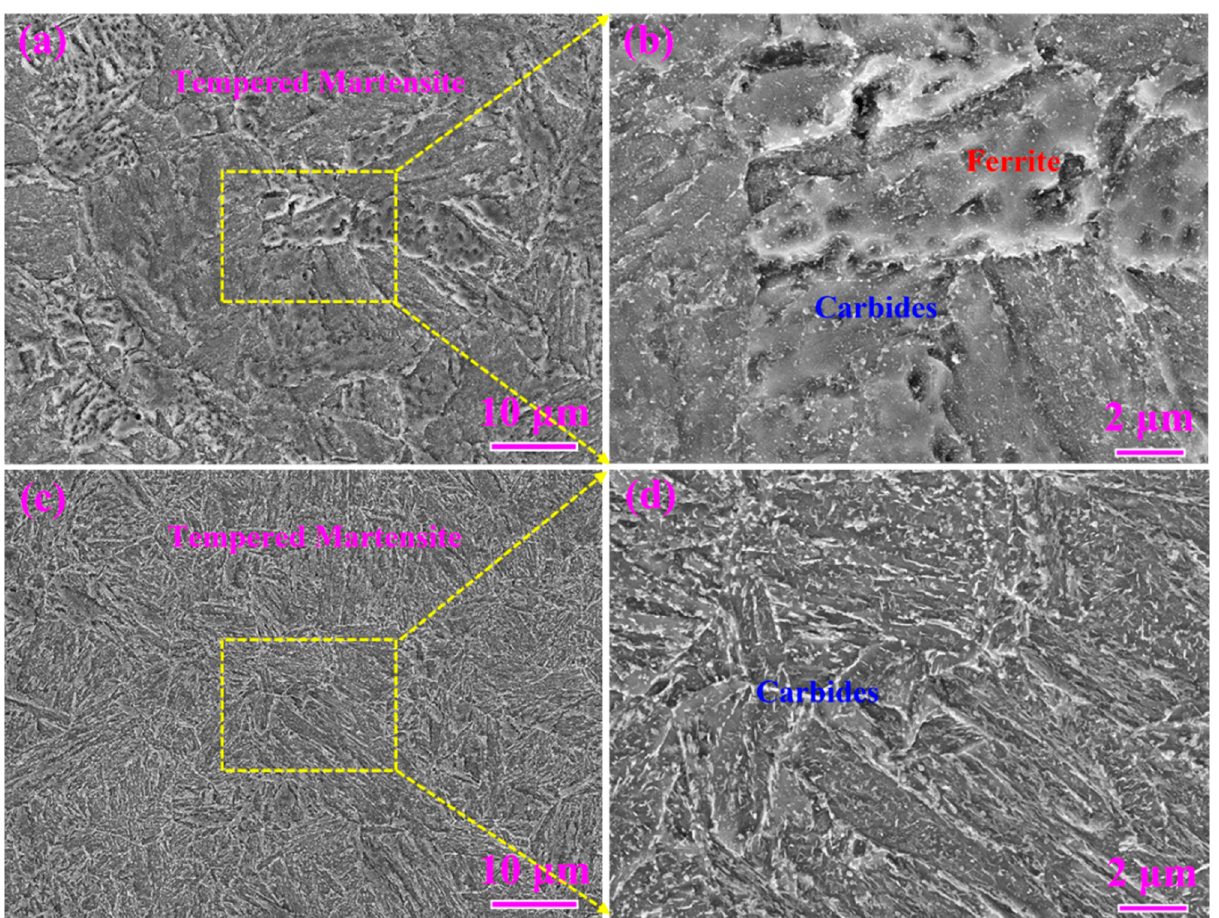
Figure 5. SEM images: ( a ) and ( b ) 0.12C-3.13Mn steel tempered at 600 °C for 5 h; ( c ) and ( d ) S4330 steel tempered at 600 °C for 5 h. (( b ) and ( d ) are the magnified zones of ( a ) and ( b ), respectively.). The RA diffraction peaks were detected in 0.12C-3.13Mn steel, while no RA diffraction peaks were detected in S4330 steel, as shown in Figure 6. The RA content in 0.12C-3.13Mn steel was calculated as 5.3%. In addition, the calculated dislocation densities were 7.168 × 10 14 and 1.434 × 10 15 /m 2 , respectively.